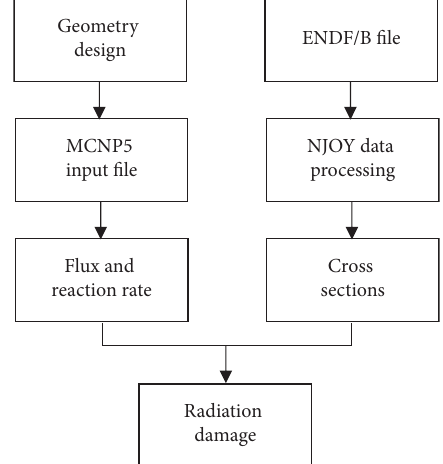
Figure 7: Two steps of radiation damage calculation in MCNP5 program using